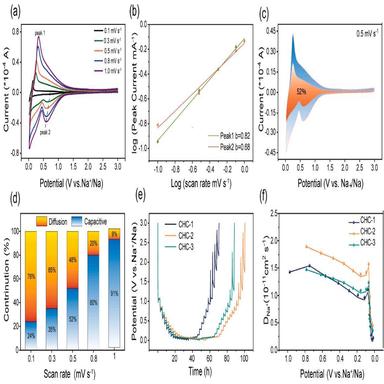
(a) CV curves of CHC-2 at different scan rates; (b) Fitted lines between the peak currents of the anodic and cathodic peaks of CHC-2 and the square root sum of the scan rate; (c–d) Calculated diffusion and capacitive contribution ratios varying from 0.1 to 1.0 mV− 1 for CHC-2; (e) GITT profiles and (f) Na+ diffusion coefficient during discharge based on the GITT.